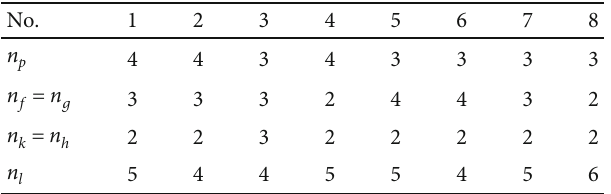
Table 2: Settings of the number of terms for the Earth-Mars rendezvous